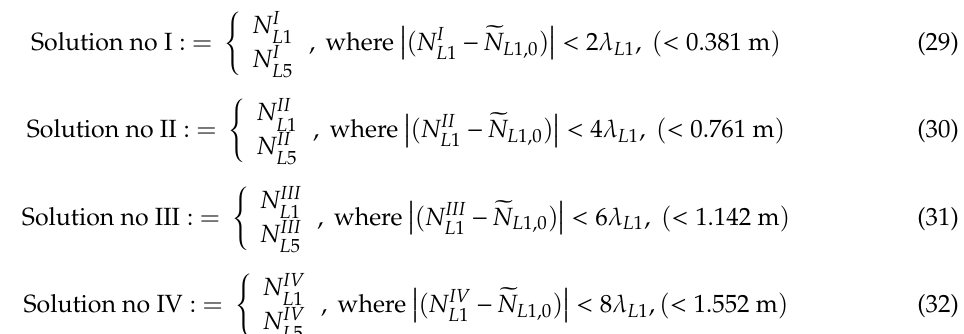
and using 5 DD observations for which the float values N L 1 N L 5